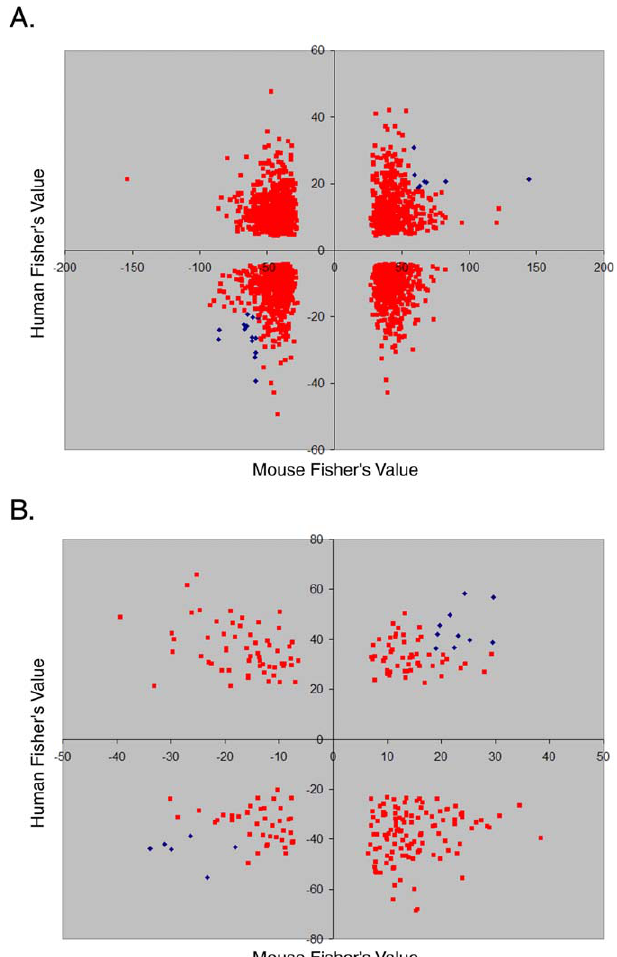
Figure 5. No Overall Correlation of Age-Regulated Expression Changes between Mouse and Human (A) Comparison of age-related expression changes for 2,578 orthologous genes in mouse and human. The y -axis indicates empirical meta-analysis Z -score for three human tissues (muscle, kidney, and brain). The x -axis shows the Fisher’s meta-analysis value for nine age-regulated mouse tissues. Each gene had a Z -value for coordinated increases with age across tissues and another for coordinated decreases. We plot the more significant of the two here. Blue diamonds show genes that are age regulated to p , 0.01 in both human and mouse ( p , 0.0001 overall). Red squares show all other genes. (B) Comparison of age-related expression changes for 280 gene sets in mouse and human. The x - and y -axes are as in A. Blue diamonds show gene sets that are age regulated to p , 0.01 in both human and mouse ( p , 0.0001 overall). Red squares show all other gene sets.